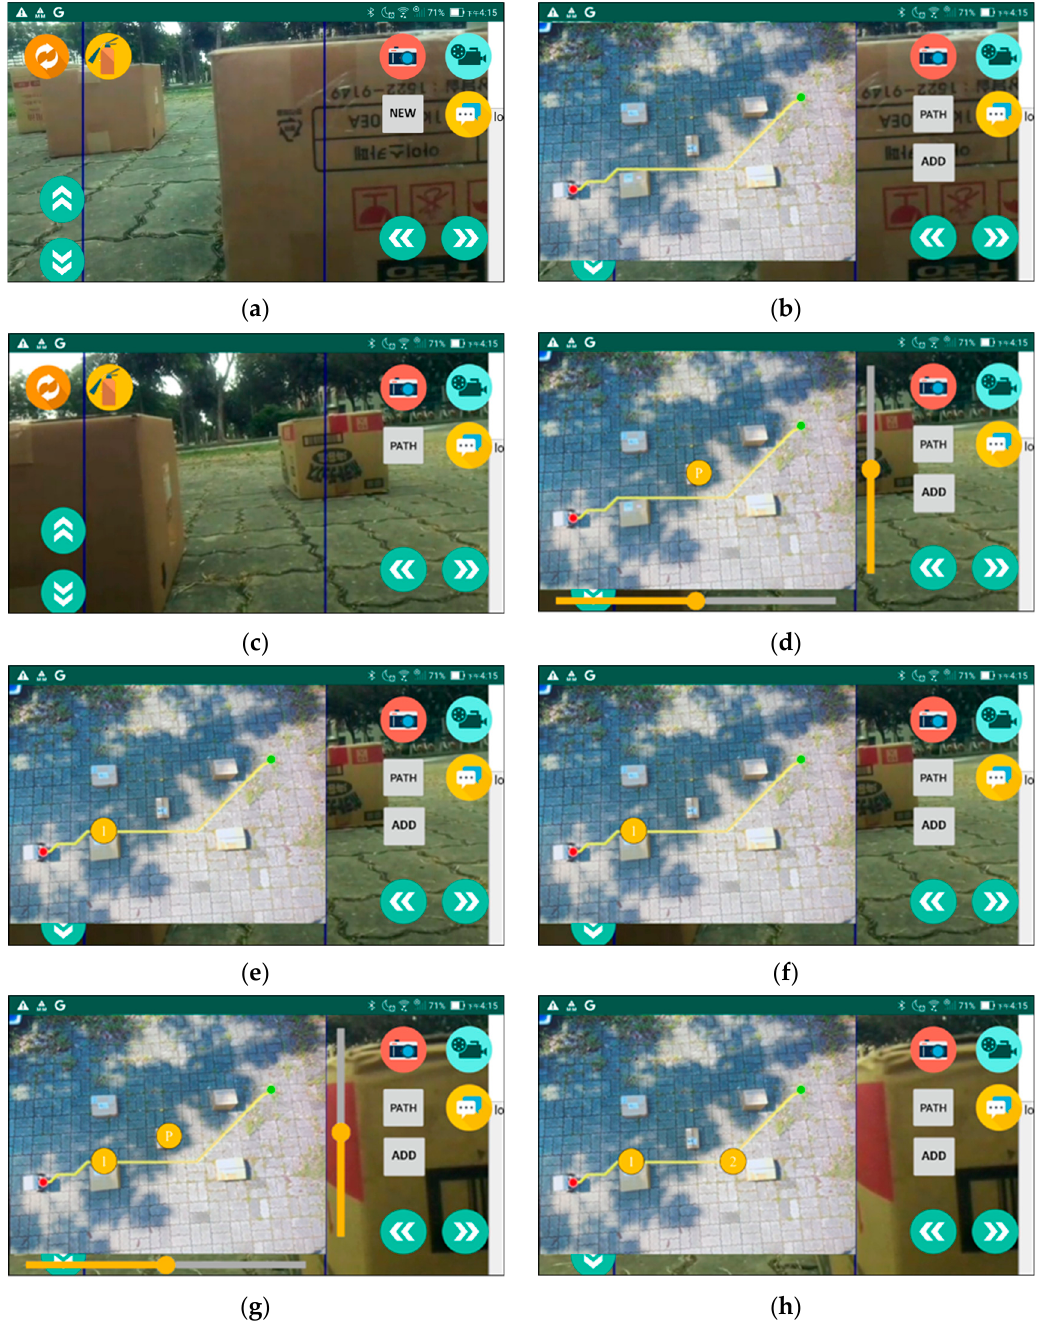
Figure 8. Control of UGV: ( a ) UGV interface; ( b ) display a planned path; ( c ) object position #1; ( d ) pop up pin point #1; ( e ) place pin point #1; ( f ) object position #2; ( g ) pop up pin point #2; ( h ) place pin point #2.